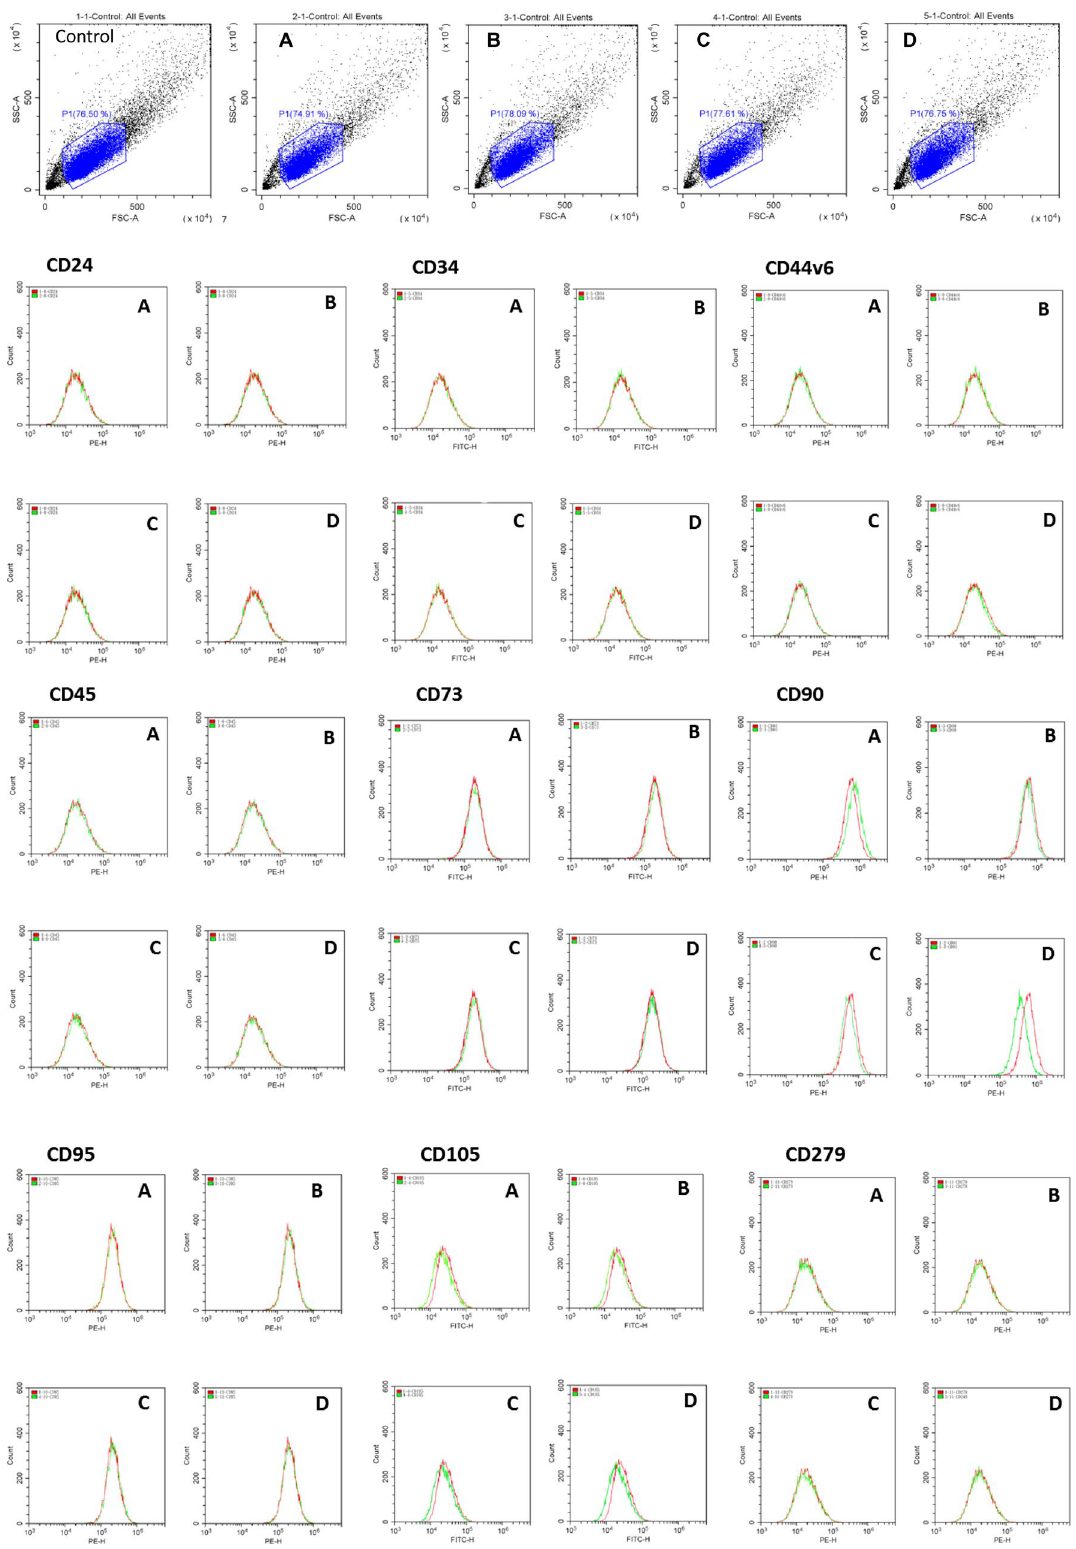
Figure 2. Fluorescence intensity curves of nine cellular markers in skin-derived stem cells (SDSCs). Nine cellular markers (CD24, CD34, CD44v6, CD45, CD73, CD90, CD95, CD105, and CD279) were screened to detect alterations in SDSCs after laser irradiation at four different intensities: ( a ) 5 μJ for 2 s; ( b ) 5 μJ for 10 s; ( c ) 20 μJ for 2 s; and ( d ) 20 μJ for 10 s. The upper portion of the figure indicates the positive cells in the indicated region. In the lower portion of the figure, the red line represents the control cells and green line corresponds to laser-irradiated cells. The x-axis indicates the intensity of fluorescence and the y-axis denotes the cell count. Treatment D considerably downregulated CD90